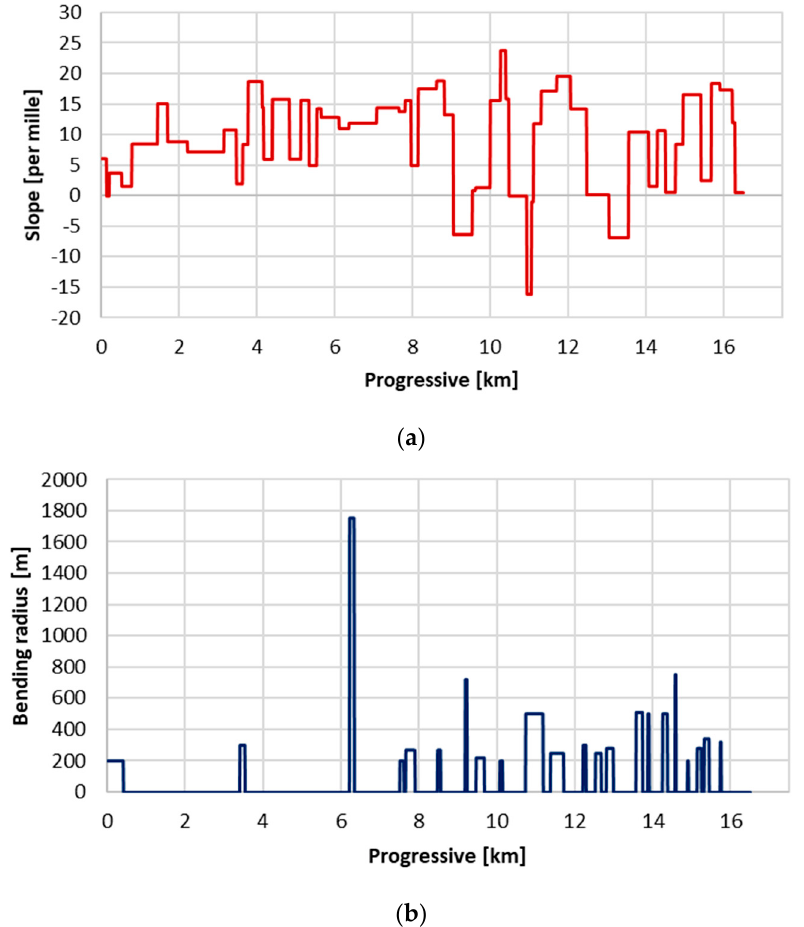
Figure 9. Track features: slopes ( a ) and curves ( b ).